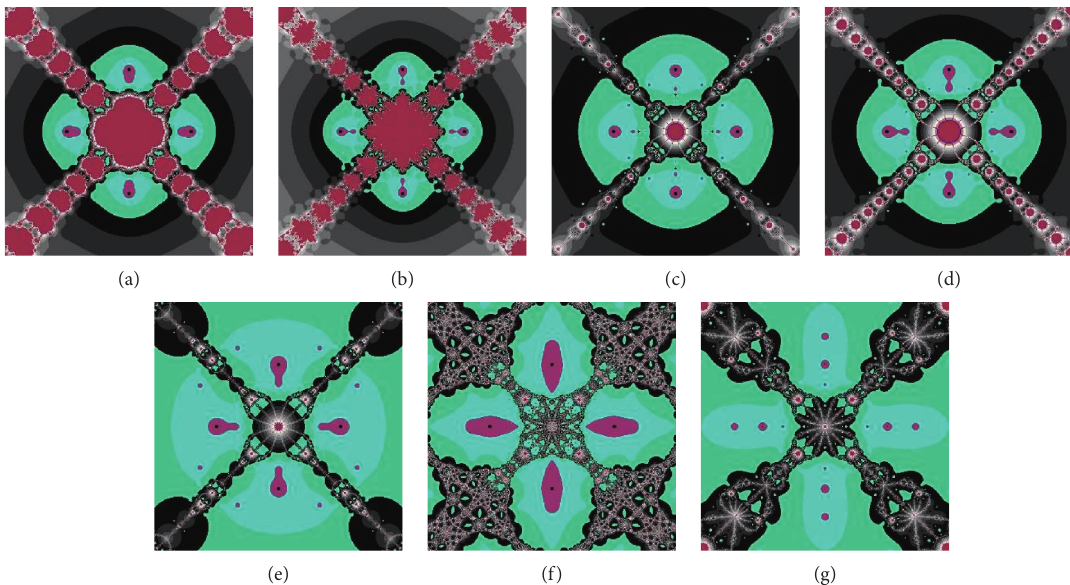
Figure 6: Polynomiographs for the polynomial p ( z ) using various iterative methods. (a) Polynomiograph for the polynomial p 6 ( z ) using NR2. (c) Polynomiograph for the polynomial p NR1. (b) Polynomiograph for the polynomial p 6 ( z ) using TM. (e) Polynomiograph for the polynomial p nomiograph for the polynomial p 6 ( z ) using Algorithm 1. (g) Polynomiograph for the polynomial p polynomial p 6